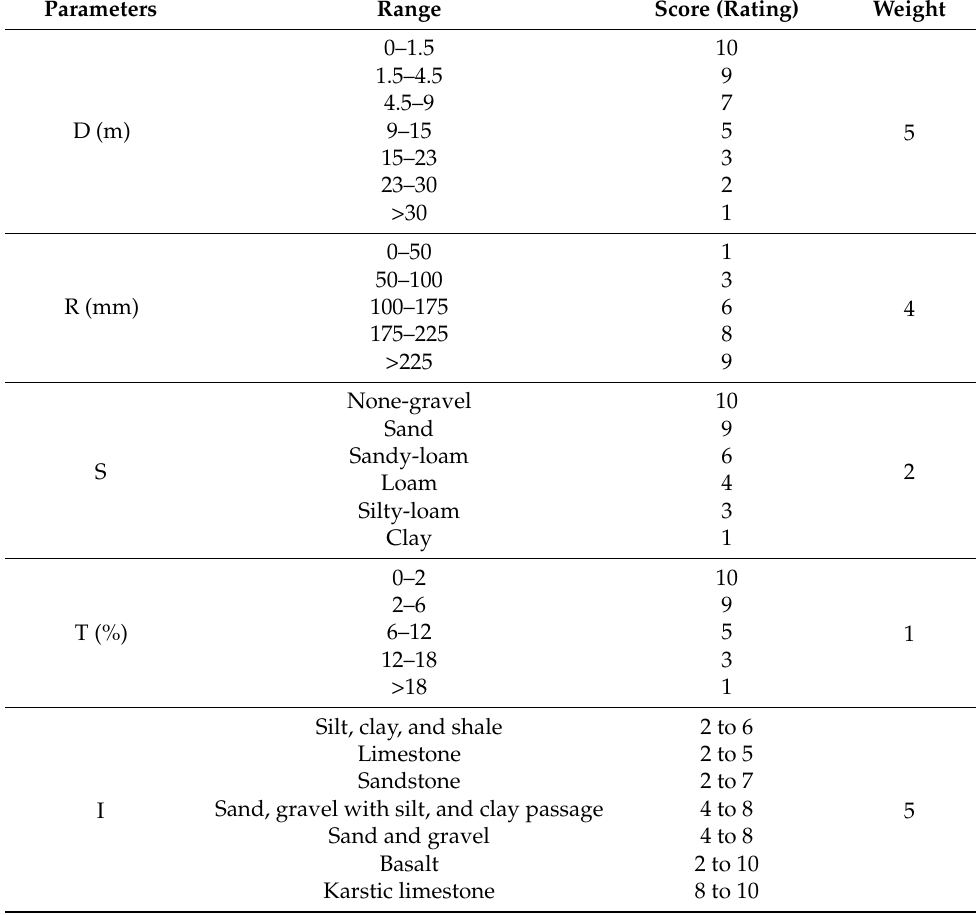
Table 1. Rating and weighting values for the vulnerability parameters [19].